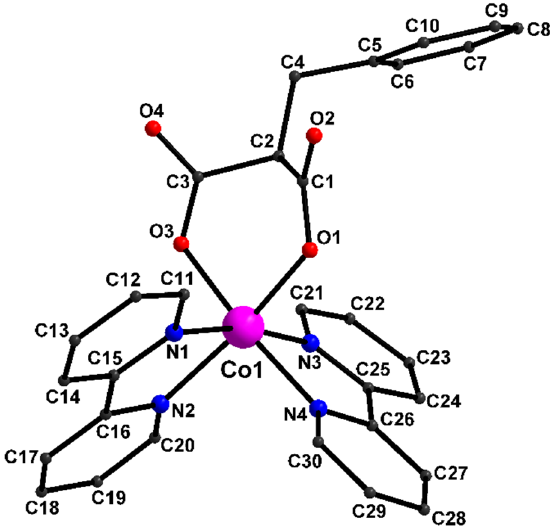
Figure 2. Structure of Complex 2. (Hydrogen atoms and solvate molecules are omitted for clarity).